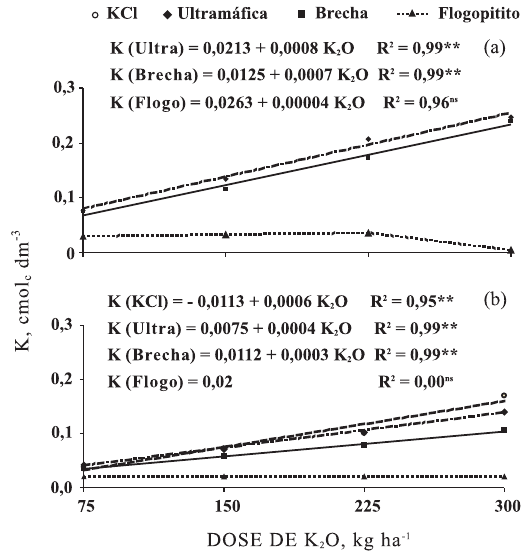
Figura 1. Potássio trocável no solo após 45 dias de incubação com pó de rochas silicáticas (a) e após cultivo de soja